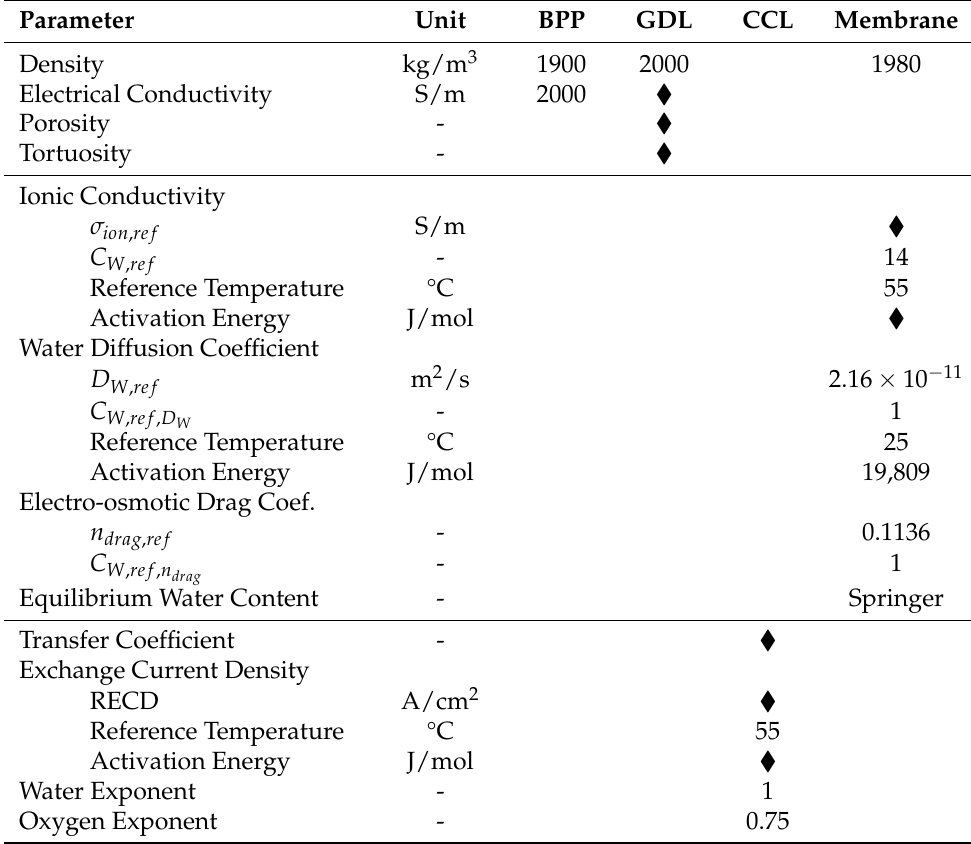
Table 4. Assumed material parameters of the investigated fuel cell. Effective values are shown for material properties of GDL. Parameters marked with (cid:7) are design variables for numerical optimiza-